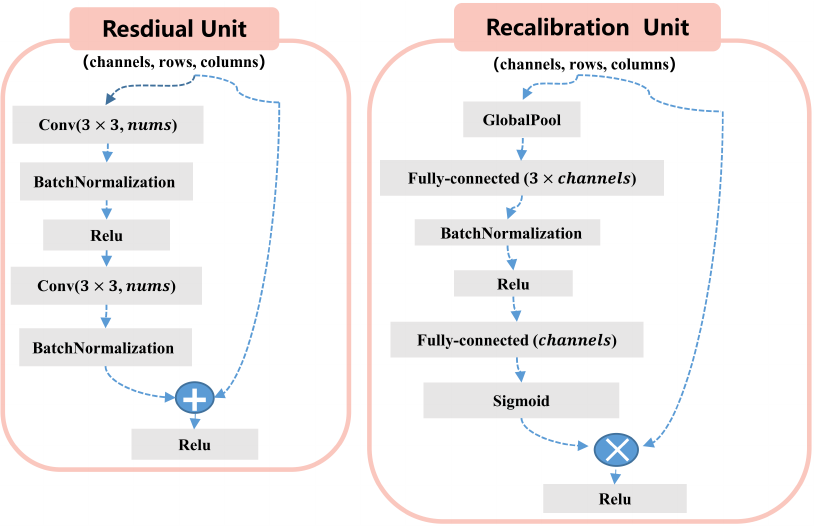
Figure 8. Sketch map of the architectures of residual unit and recalibration unit in basic